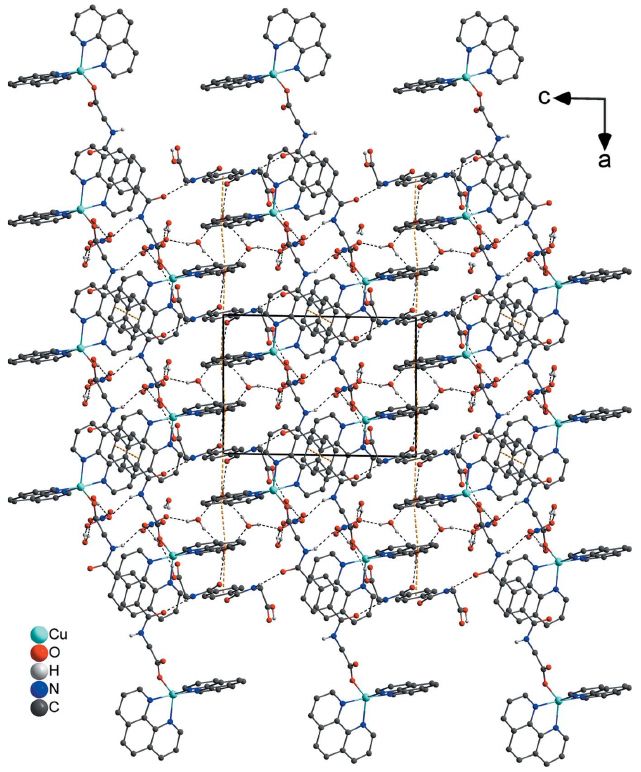
Figure 2 The crystal packing of the title structure in a view along the b axis. Selected (cid:2) – (cid:2) stacking interactions between phenanthroline ligands and N , N 0 -(1,4-phenylenedicarbonyl)diglycine solvent and phenanthroline ligands are shown as orange dashed lines as well as classical hydrogen bonding indicated by black dashed lines. The hydrogen atoms of aromatic moieties and methylene groups have been omitted for clarity.